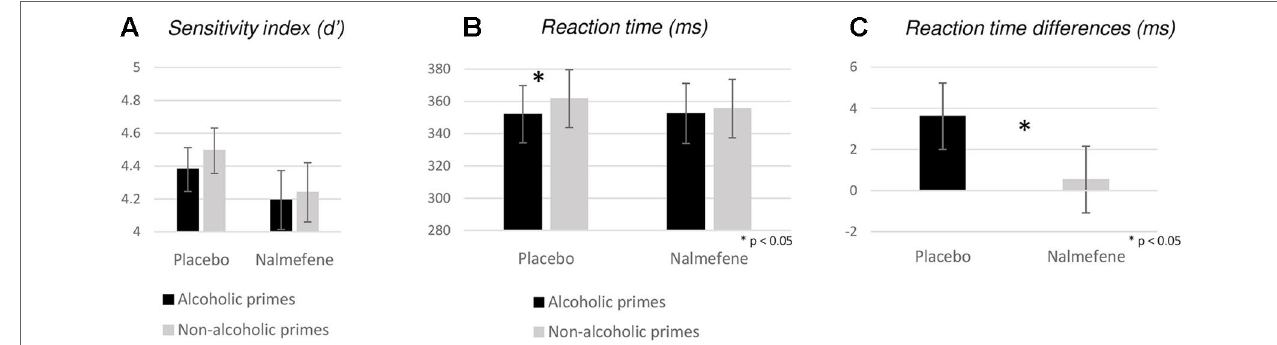
FIGURE 4 | Behavioral measures ( A : sensitivity index, B : reaction times, C : reaction time differences for nonalcoholic–alcoholic primes) obtained for experiment 2. Bars represent mean; error bars depict standard errors. Reaction times were calculated for Go responses only. Stars depict significant ( p < 0.05) disparities between reaction times and differences of reaction times obtained in different priming and grouping